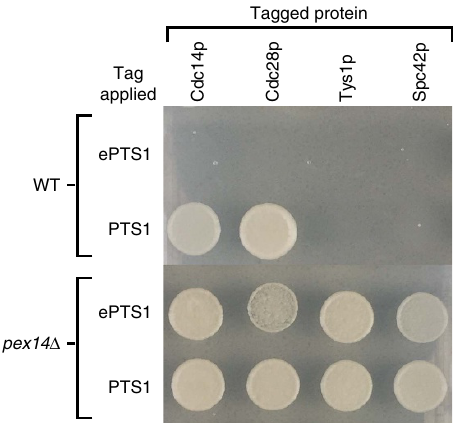
Figure 4 | The ePTS1 tag modularity allows for rapid sequestration of a variety of proteins. Sequestration of essential proteins and subsequent growth arrest was tested using yeast strains with galactose-inducible control of Pex5p expression. Strains shown were modified so that one of four essential proteins (Cdc14p, Cdc28p, Tys1p or Spc42p) was individually fused to either ePTS1 or naı¨ve PTS1. Control strains with a permanently defective peroxisomal import system ( pex14 D ) were also included. Strains were spotted onto agar plates with galactose to induce Pex5p expression and grown for 48h. WT, wild